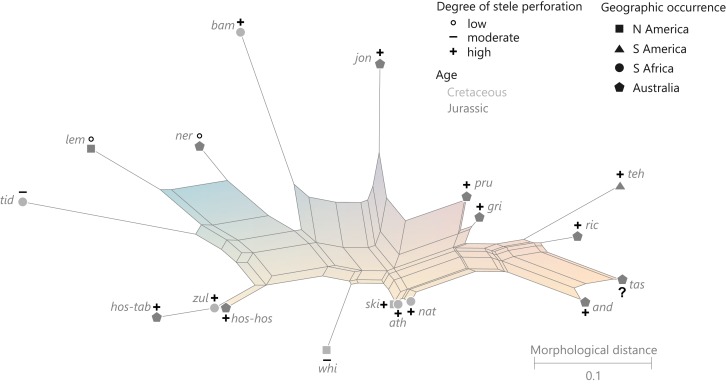
Planar network (neighbour-net) for all operational units of genus Osmundacaulis (subfamily incertae sedis, Osmundaceae).The three-letter labels indicate the first three letters of the specific epithet of the relevant taxon.